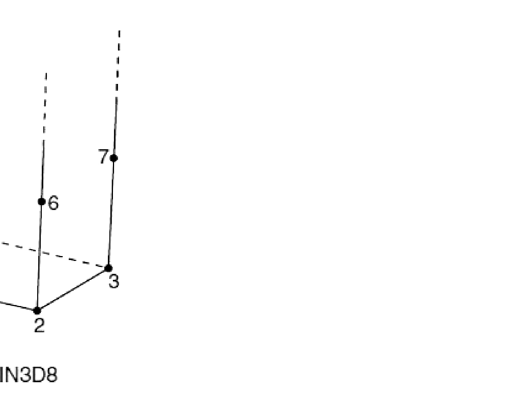
Figure 7. Adopted element type in numerical